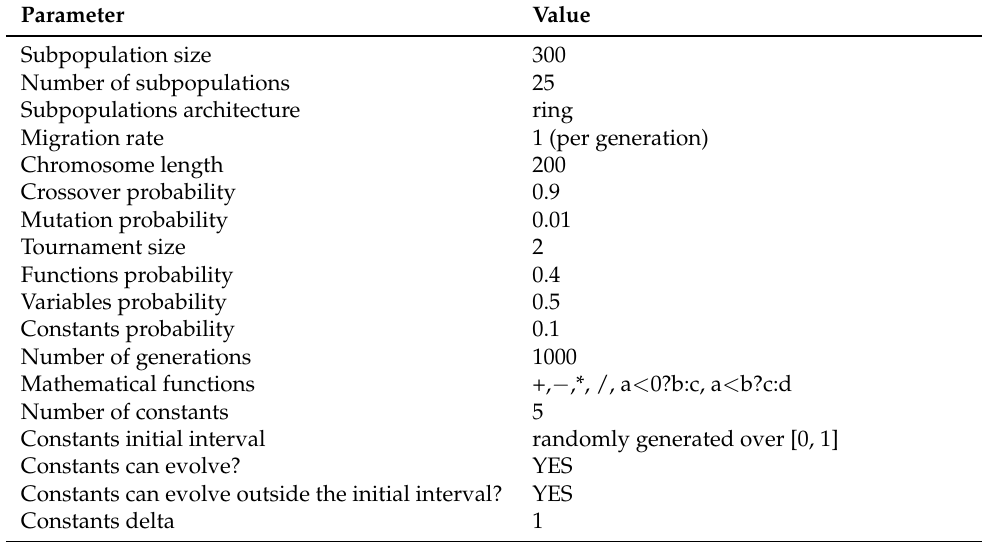
Table A2. MEP parameters.